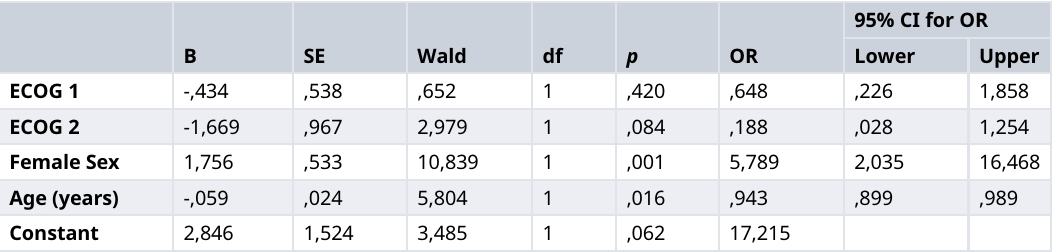
Table 2. Logistic regression predicting Likelihood of Systemic Adverse Reactions based on Age, Sex and ECOG